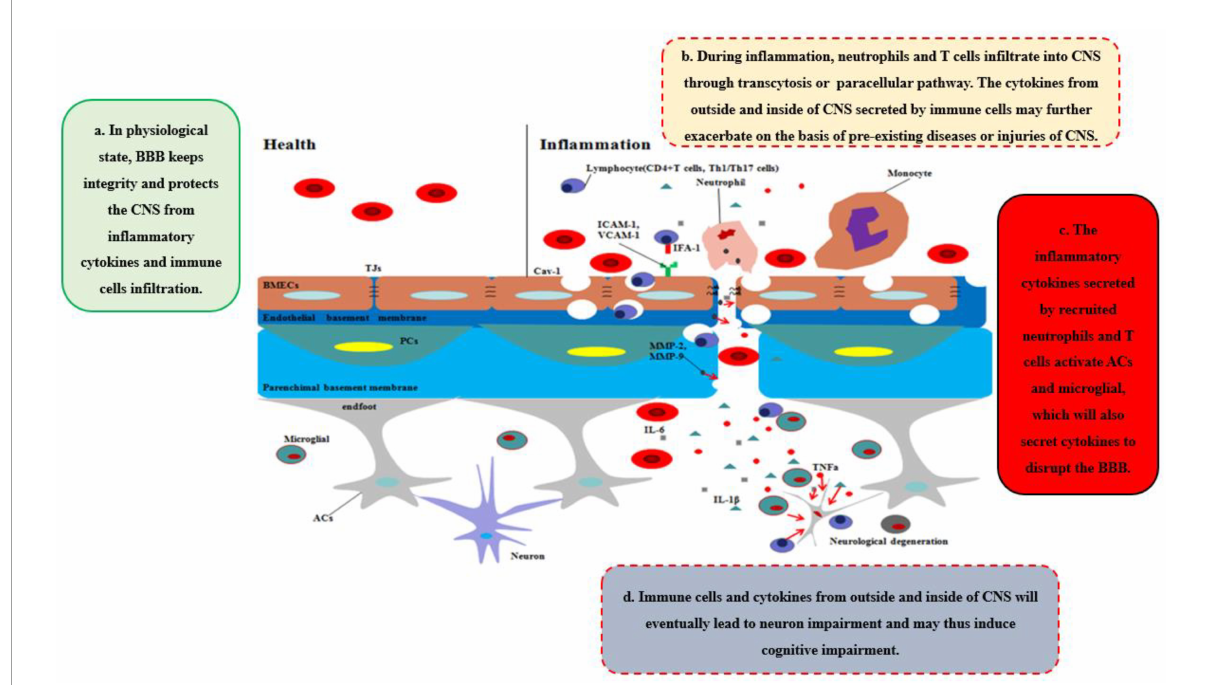
FIGURE2 Disruption of BBB recruits the immune cells and cytokines into CNS. In healthy status, the integrity of BBB protects the CNS from toxins, pathogens, inflammatory cytokines, and immune cell infiltration. However, during inflammation, neutrophils and T cells from outside of CNS are recruited into CNS through transcytosis or paracellular pathway, which secrete pro-inflammatory cytokines and chemokines to further disrupt the integrity of BBB and deteriorate the CNS disease or injuries. Moreover, ACs and microglia are further activated by the cytokines, chemokines, and immune cells outside of CNS, which integrated with inflammatory factors outside of CNS will eventually lead to neurodegeneration and may induce cognitive